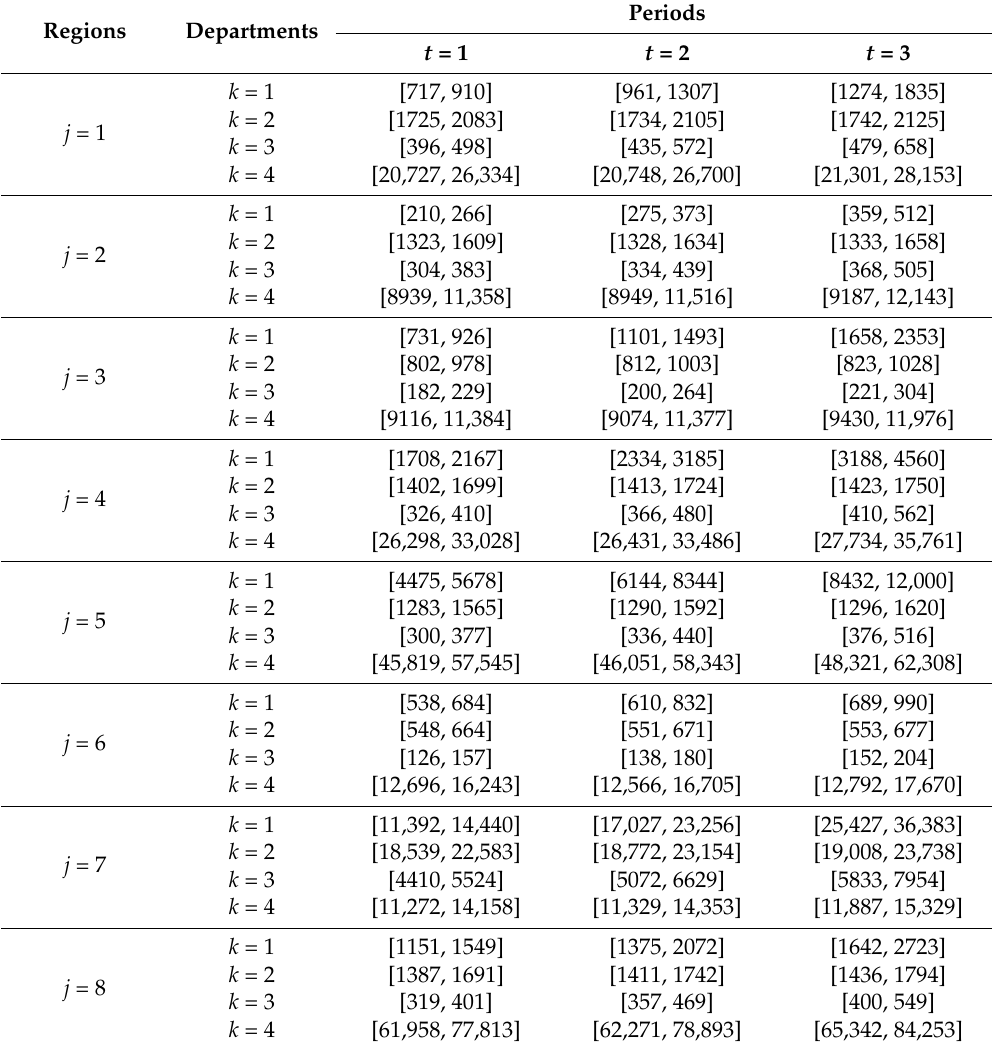
Table 2. Initial water resource allocation in the Yinma River Basin (10 4 m 3 /year).